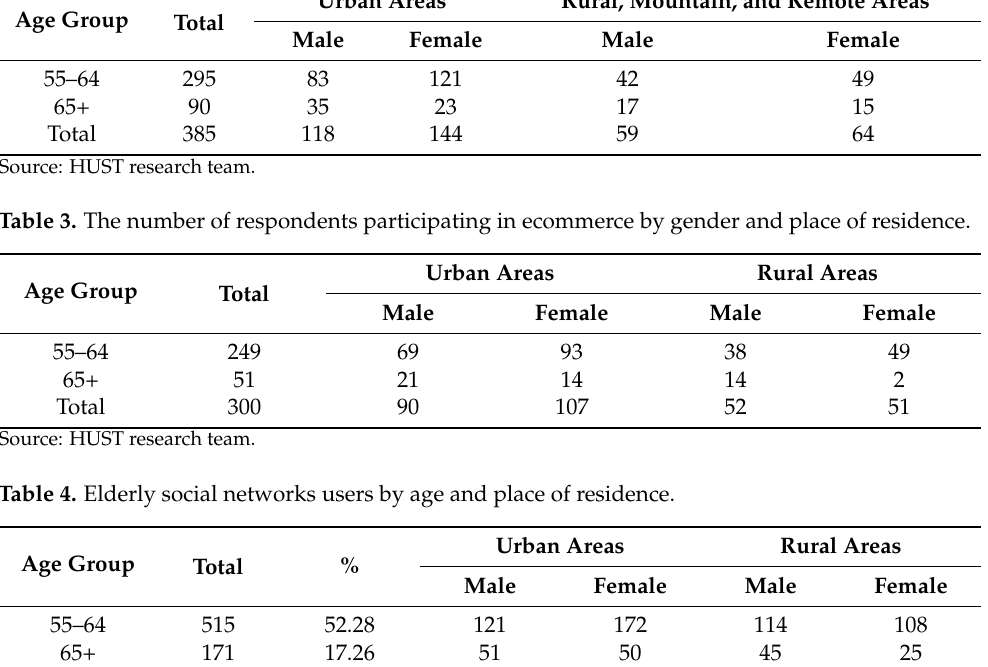
Table 2. The number of respondents using online public services by residence and age. Age Group Total